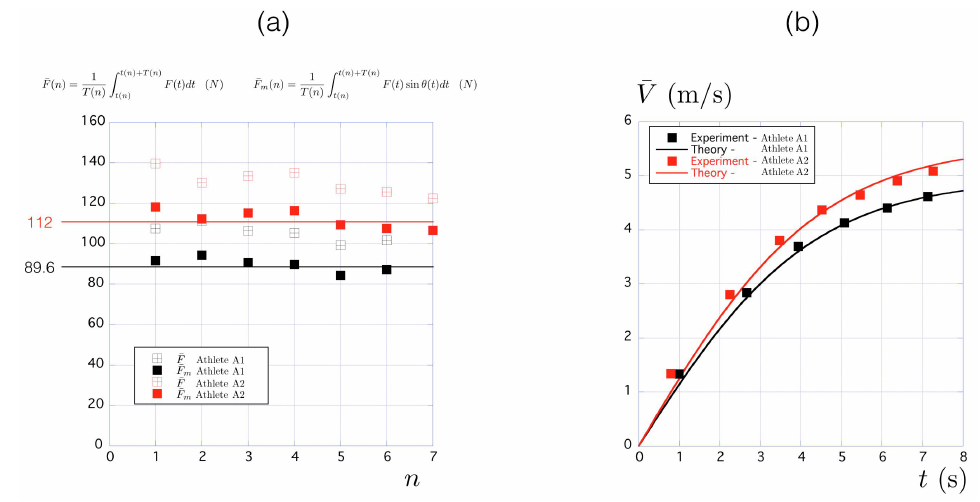
Figure 13. ( a ) Evolution of the mean total force F and mean propulsive component F m = Fn θ over the first n cycles of the standing start are presented in Figure 9 ( b